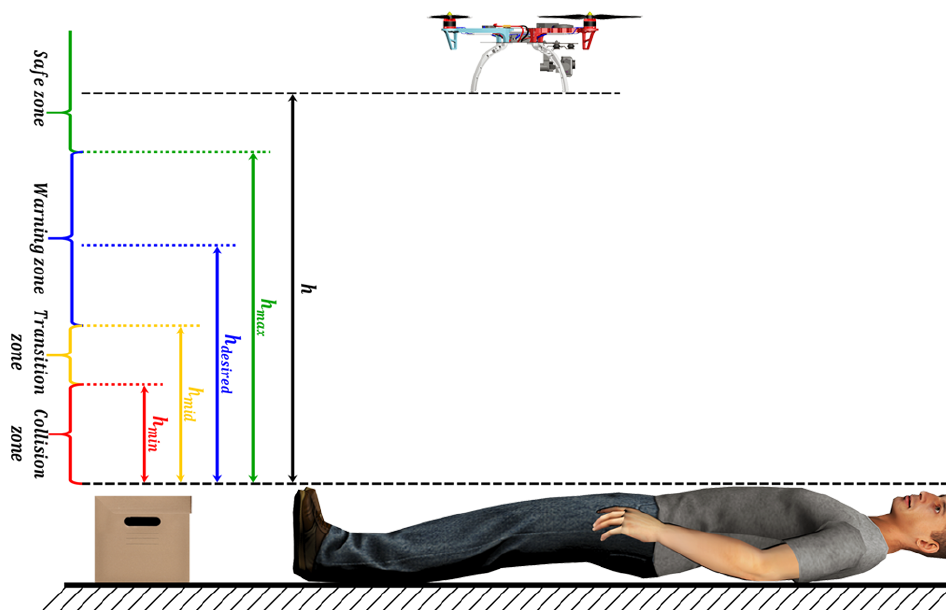
Figure 8. Dynamic Parametric Field algorithm danger zones.